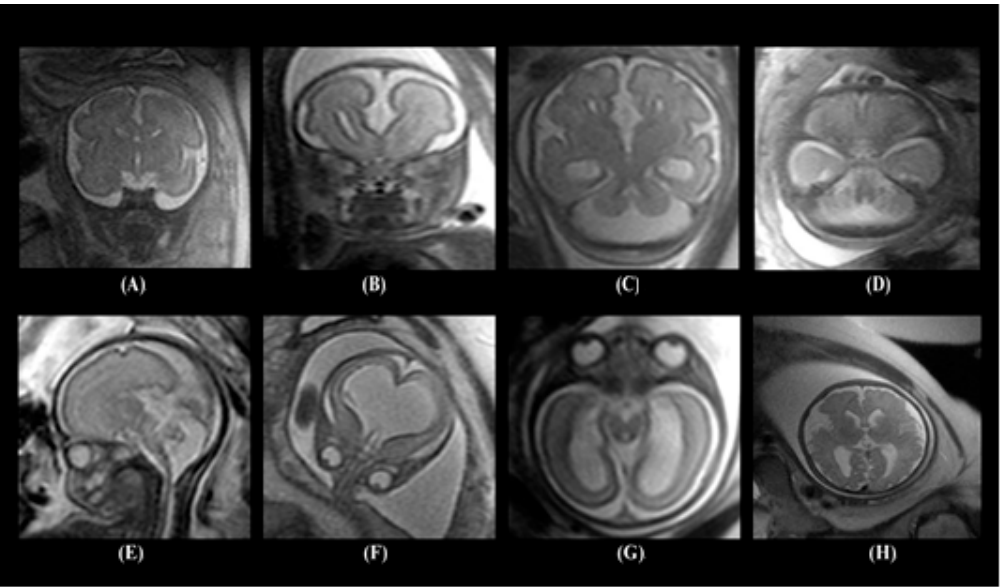
Figure 1. Images of different embryonic neurodevelopmental disorders: ( A ) normal embryonic brain, ( B ) agenesis of the corpus callosum, ( C ) colpocephaly, ( D ) mega-cisterna manga, ( E ) Dandy–Walker malformation, ( F ) agenesis of the septi pellucidi, ( G ) cerebellar hypoplasia, and ( H ) polymicrogyria.